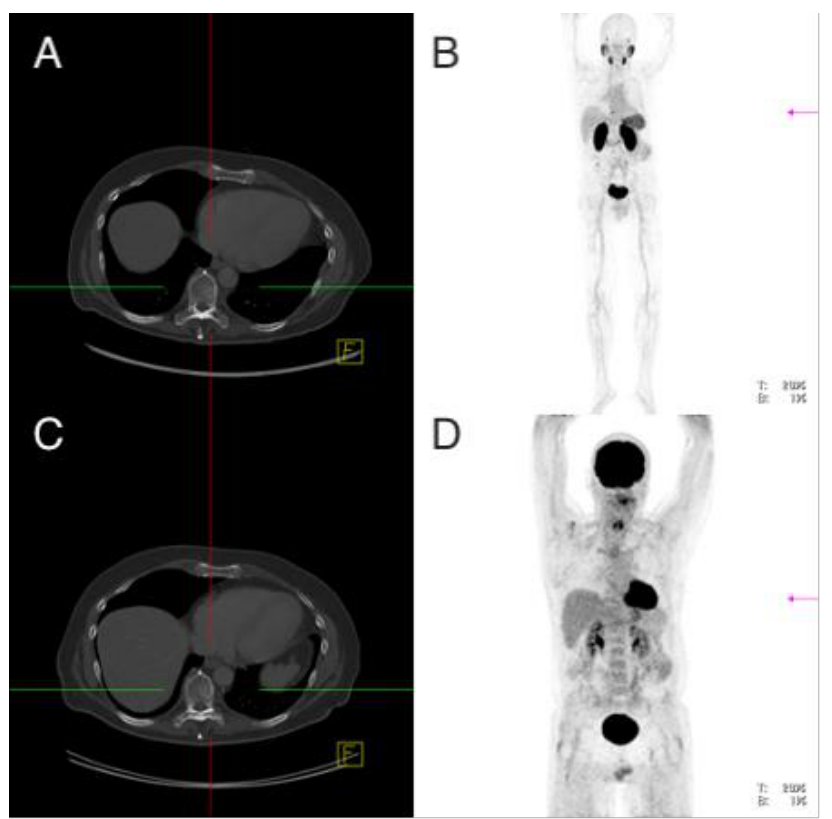
Figure 6. Patient 8. 68 Ga-PSMA-PET/CT ( A , B ), 18 FDG-PET/CT ( C , D ). Morphologic pattern of thoracic vertebral body 9 with osseous metastasis in CT. A second 68 Ga-PSMA-PET/CT which was not included in our comparative analysis and which was conducted 187 days later, revealed a disease progression with multiple lesions with clearly pathologically increased PSMA expression (median SUVmax 10.0 (6.0 – 15.0) (Figure 7). Therefore, the patient received two cycles of 177 Lu-PSMA therapy in the sense of theranostics within the framework on an individual therapeutic approach (Figures 8 and 9). Based on the experience gained in the treatment of prostate and neu- roendocrine carcinomas, 6.3 GBq were applied intravenously in the first cycle and 7.4 GBq were administered in the second cycle eight weeks later. Despite the fact that no side effects were evidenced after the first cycle, the patient experienced temporary nausea after the second one. During follow-up, stable disease was described until seven months after the first cycle, after which there was an increase in thyroglobulin levels; another three months later, FDG-positive metastases appeared for the first time in an 18 F-FDG-PET/CT performed in the context of the tumor marker elevation. IHC analysis: Unfortunately, no tissue sample could be examined for this patient.